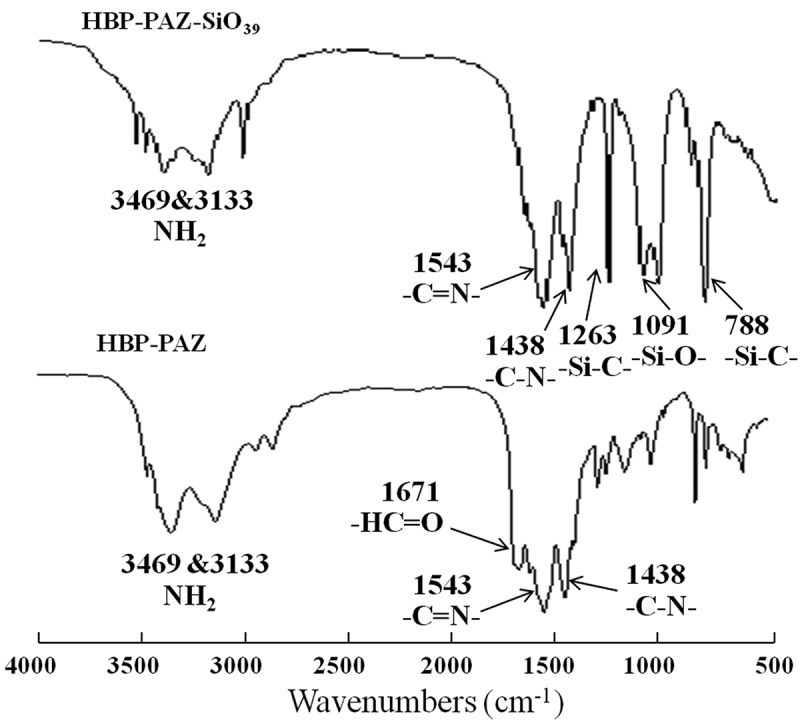
IR spectra of HBP-PAZ and HBP-PAZ-SiO39.